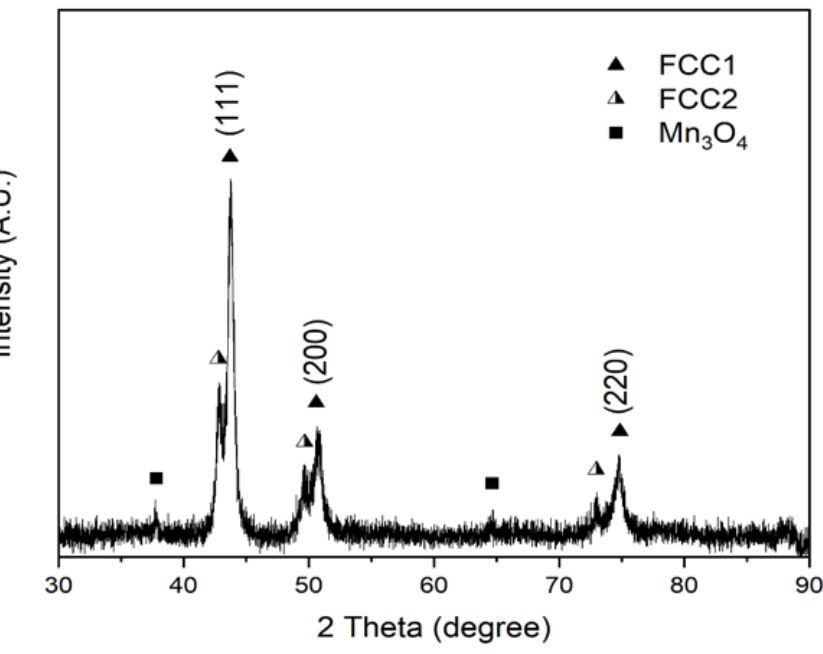
Figure 3. XRD pattern of equiatomic CrMnFeCoNiCu, exhibiting peaks for two FCC phases and minor amounts of MnO identified on the basis of d-spacing. Figure 3. XRD pa tt ern of equiatomic CrMnFeCoNiCu, exhibiting peaks for two FCC phases and Table 2. Calculated lattice constants of FCC1 and FCC2 minor amounts of MnO identi fi ed on the basis of d-spacing. Table 2. Calculated la tt ice constants of FCC1 and FCC2 phases.